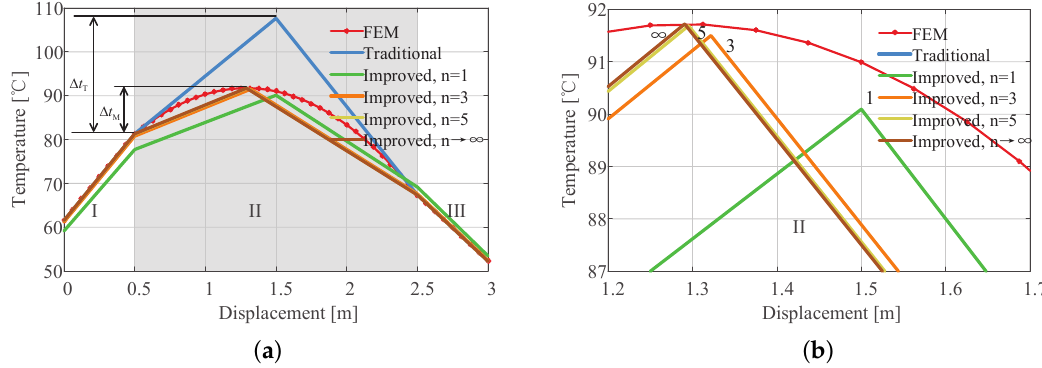
Figure 6. ( a ) Temperature distribution in asymmetric heat dissipation with heat source. ( b ) Enlarged view of local area.